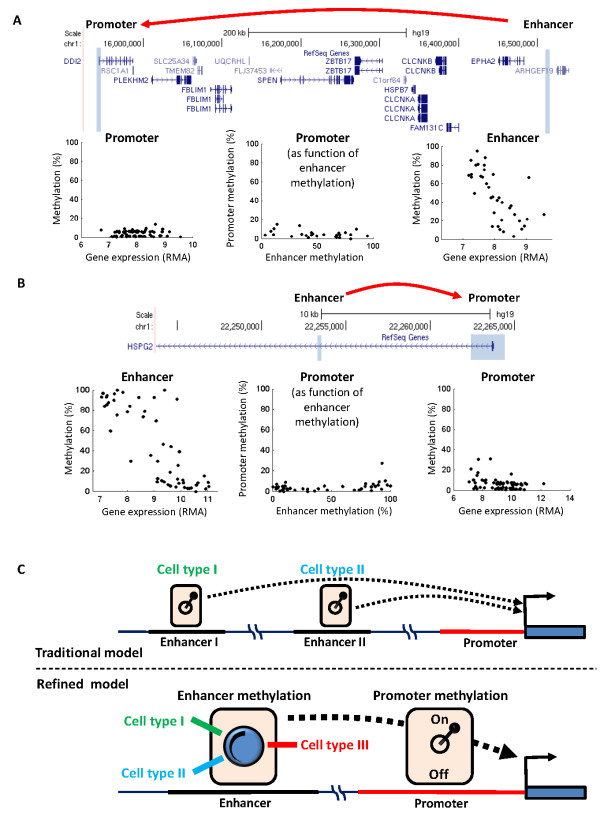
Enhancer methylation defines gradients of cell-type transcription levels. (A)An example of gene-enhancer pair in the RSC1A1 gene region. Gray boxes mark an enhancer methylation site associated with expression of the RSC1A1 gene, and the promoter of this gene. The x-y scatters below the map show methylation versus expression across the cell types for the promoter methylation sites (left), and for the enhancer site (right). The middlescatter shows the methylation of the promoter sites versus methylation of the enhancer across the cell types. (B) Similar to A, but for an enhancer within the first intron of the HSGG2 gene, interacting with HSGG2expression. (C) Models for enhancer control of cell-type expression levels. Upper panel: The traditional model suggesting that enhancers act like cell-type-specific switches of gene transcription, each of them supports expression in a given cell type (or types). Bottom: A refined model suggesting that even a single enhancer site may functions as a dimmer switch, mediating gradients of transcription levels across many cell types as long as the promoter is unmethylated and thus permissive for transcription. RMA, (Robust Multi-chip Average).